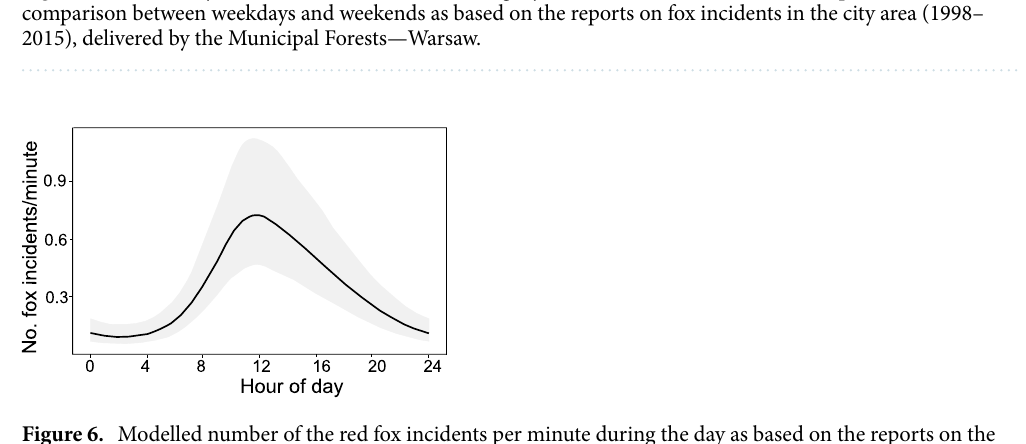
Figure 6. Modelled number of the red fox incidents per minute during the day as based on the reports on the red fox incidents in the city area (1998–2015), delivered by the Municipal